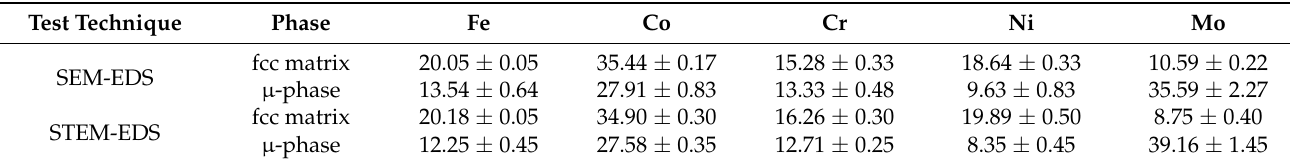
Table 1. The chemical composition (at.%) of the fcc matrix and µ -phase obtained by SEM-EDS and STEM-EDS in the Mo 10